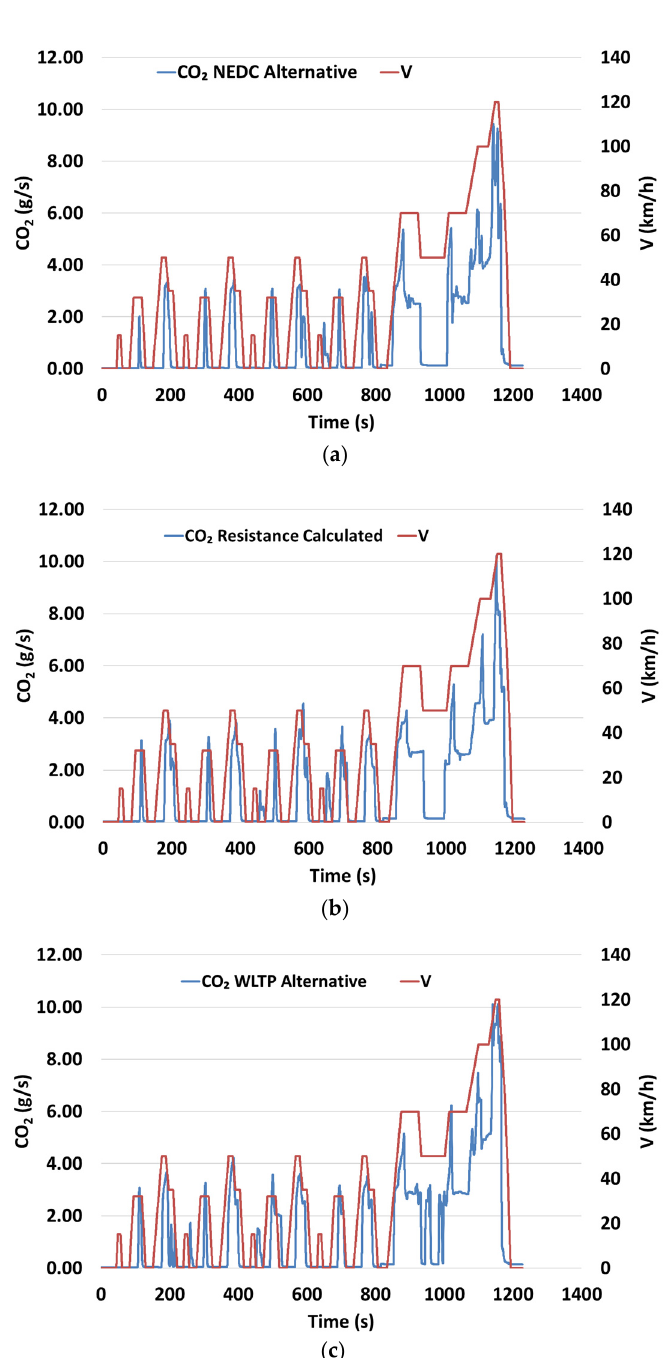
Figure 3. Comparison of CO 2 emissions for the analysed dynamometer load setting methods, in urban (UDC) and extra-urban (EUDC) phases and for the entire NEDC cycle.